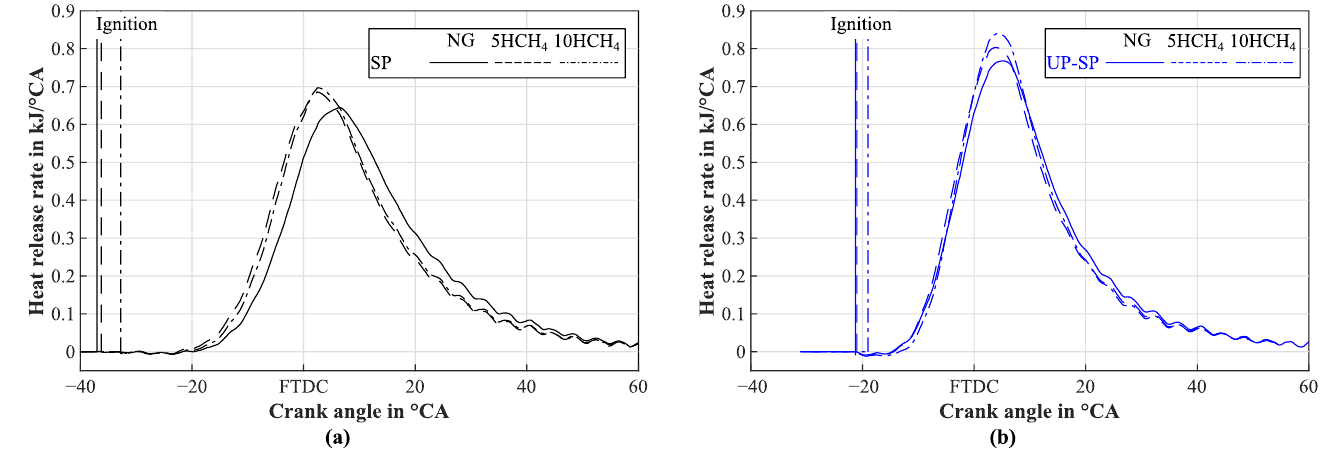
Figure 7. ( a ) Heat release rate for spark plug at CoC = 8 °CA aFTDC and air – fuel equivalence ratio 1.7 ; ( b ) Heat release rate for unscavenged spark plug at CoC = 8 °CA and air – fuel equivalence ratio ( b ) Heat release rate for unscavenged spark plug at CoC = 8 ◦ CA and air–fuel equivalence ratio 1.7 .